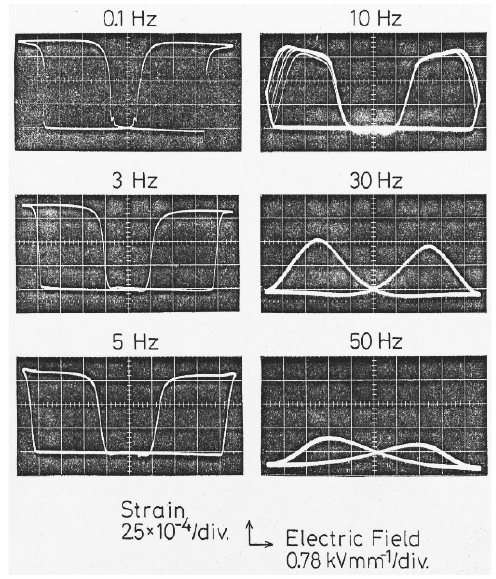
Figure 14. Transverse induced strain response as a function of drive frequency measure in Pb 0.99 Nb 0.02 [(Zr 0.6 Sn 0.4 ) 0.94 Ti 0.06 ] 0.98 O 3